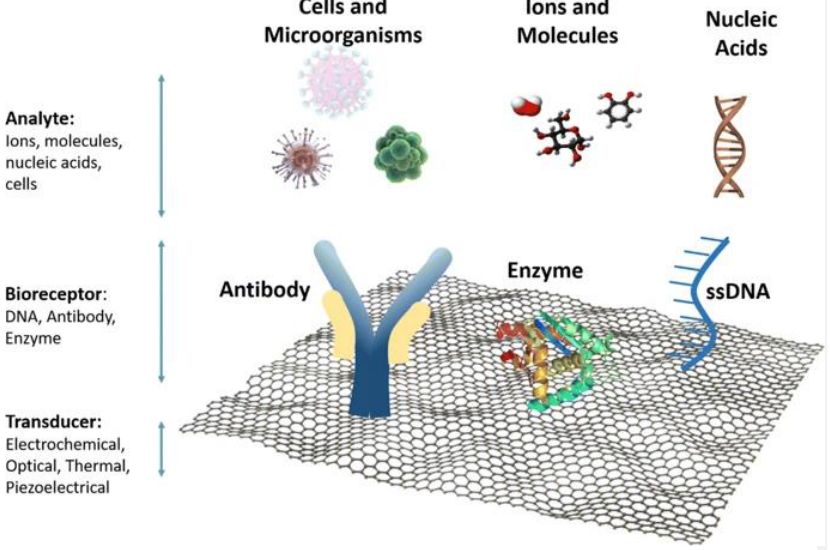
Figure 4 Schematic diagram of Graphene-based biosensors for different biomolecules 214 Figure 4. Schematic diagram of graphene-based biosensors for di ff erent